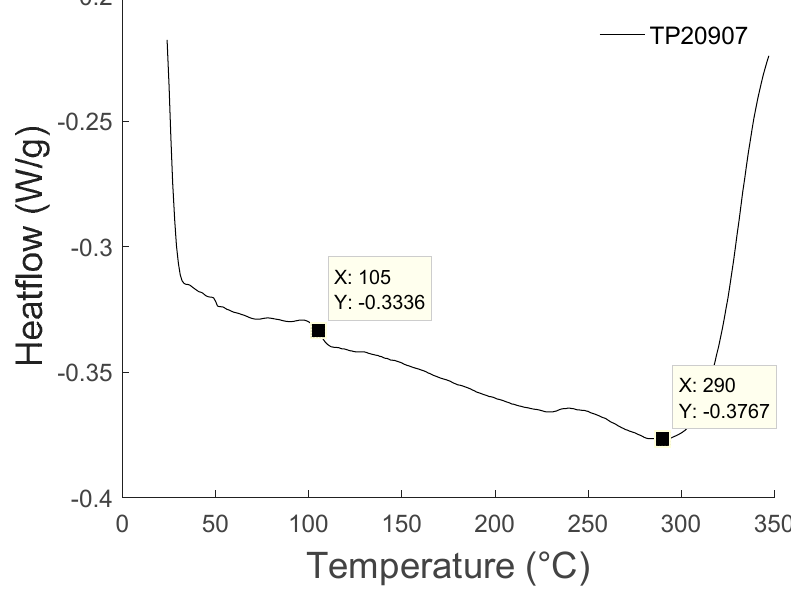
Figure 2. DSC curve of Premix PREPERM™ TP20907.